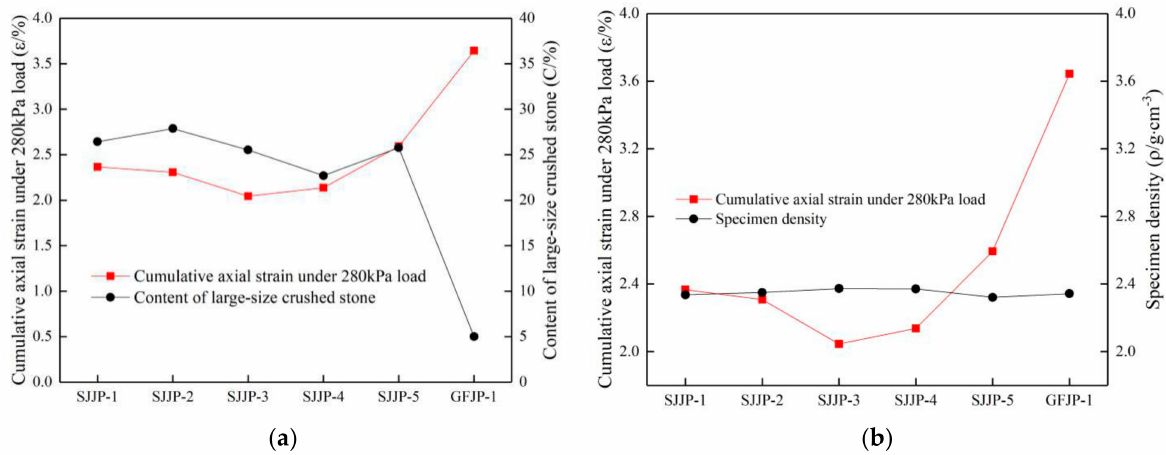
Figure 15. ( a ) Relationship between cumulative axial strain and content of large-size crushed stone content under load of 280 kPa; ( b ) relationship between cumulative axial strain and specimen density under load of 280